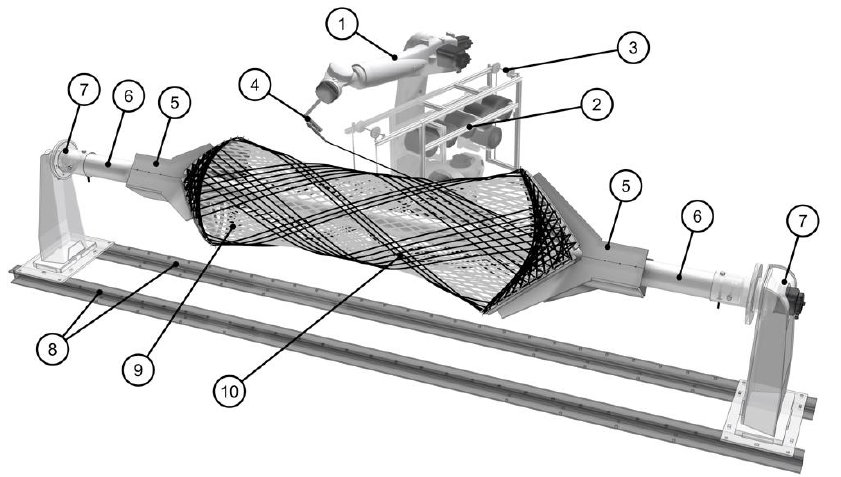
Figure 1. Robotic coreless filament winding setup for the manufacturing of the BUGA composite components: 1, industrial robot (6-axis); 2, robot-mounted creel; 3, fiber tension mechanism; 4, robotic winding end effector; 5, winding frame; 6, continuous steel tube; 7, one-axis positioner (external axis); 8, H-shaped steel beams; 9, underlaying glass fiber body; 10, carbon fiber reinforcement. © ICD/ITKE University of Stuttgart.